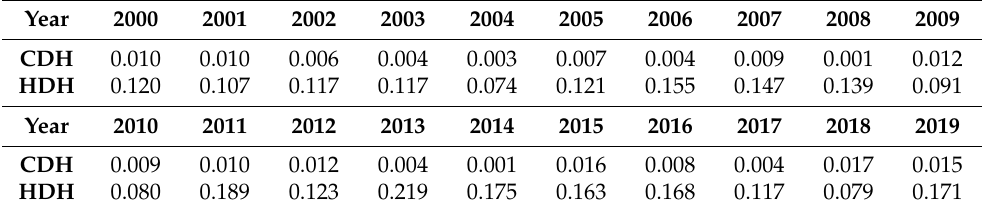
Table 2. D values (Kolmogorov–Smirnov test) for testing the goodness of fit between observed and estimated cumulative frequencies of the exceedances.